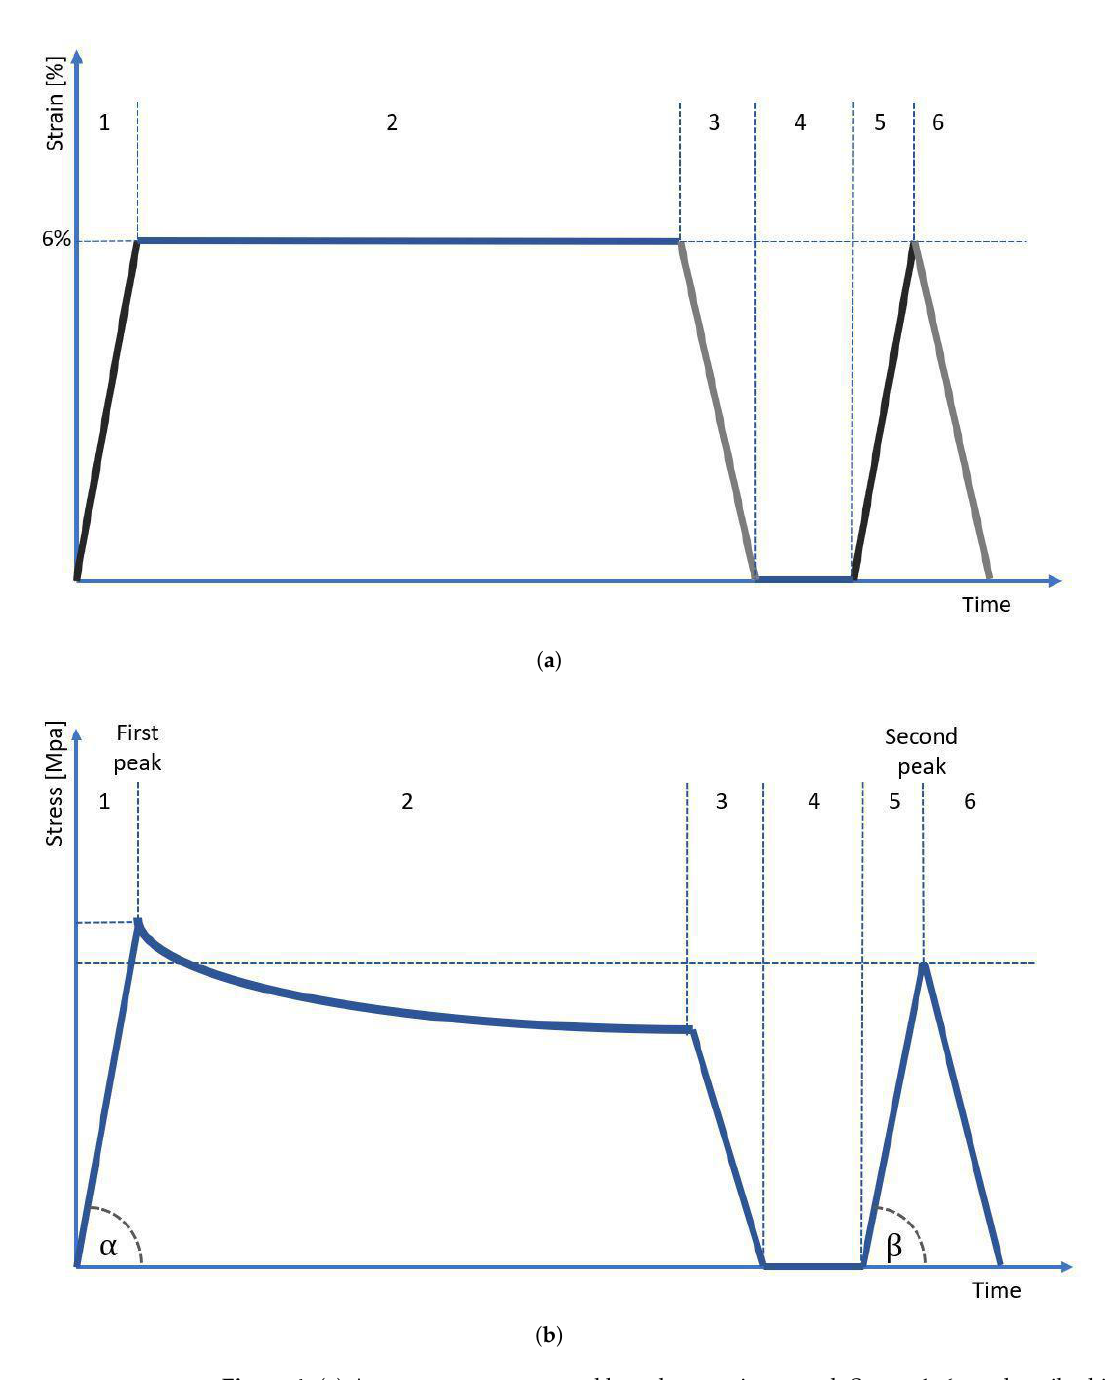
Figure 4. ( a ) A measurement protocol based on strain control. Stages 1–6 are described in the text, ( b ) the diagram shows the course of stress on the sample over time. The angles α and β were used to calculate the elasticity